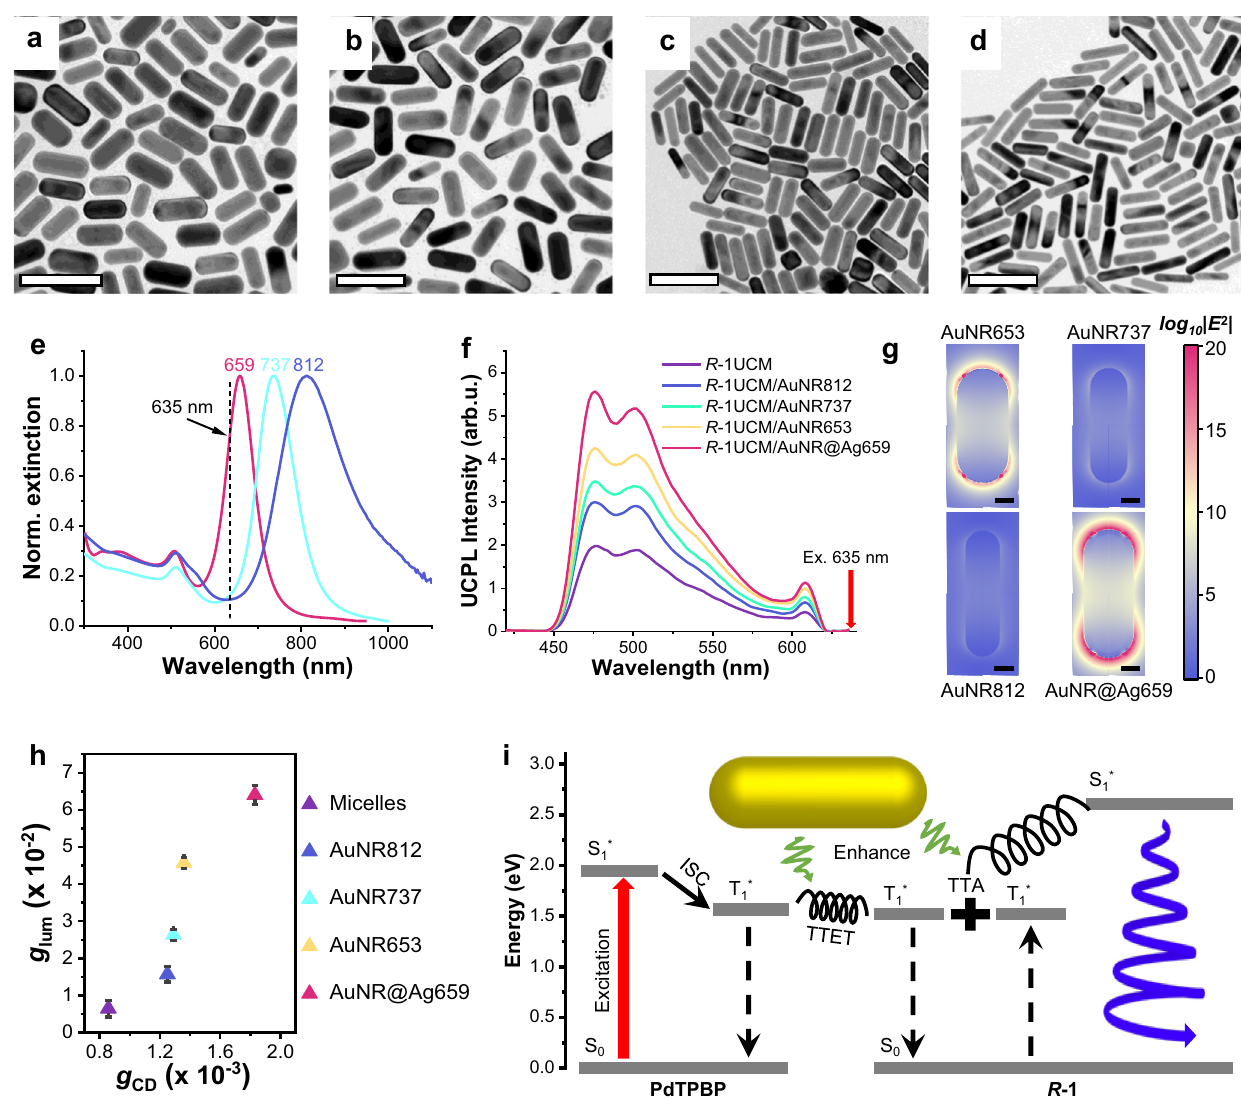
Fig. 4| Electromagnetic fi eld-relatedenhancement ofphotoupconversionand CPL.a – d TEMimages of a AuNR653, b AuNR@Ag659, c AuNR737,and d AuNR812. Scale bar=200nm. e Normalized extinction spectra of AuNR737 (cyan), AuNR812 (blue), and AuNR@Ag659 (red). The black dashed line indicates the excitation at 635nm. f Upconverted photoluminescence spectra of R − 1UCM and R -1UCM cou- ples with different plasmonic nanorods in deaerated water under excitation of 635nm laser. [ R -1]=5×10 − 5 molL − 1 , [PdTPBP]=10 − 5 molL − 1 , [CTAB]=10 − 2 molL − 1 , molar ratio AuNR653/ R − 1=4.2×10 − 6 /1, 4.2×10 − 6 /1, 3.0×10 − 6 /1, and 2.6×10 − 6 /1 for